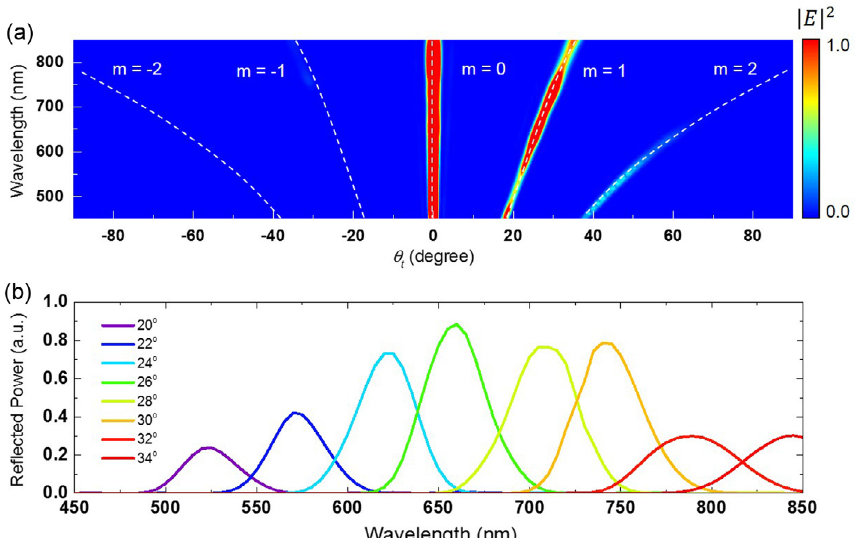
Figure 3. Angular distribution of the simulated transmitted power at far-field from the metasurface. (a) Simulated 2D contour for far-field transmitted powers as a function of transmission angles h t ( x -axis) and wavelength ( y -axis). (b) Simulated anomalous transmitted power spectra for different transmission angles from 20 (cid:3) to 34 (cid:3) with 2 (cid:3) interval,